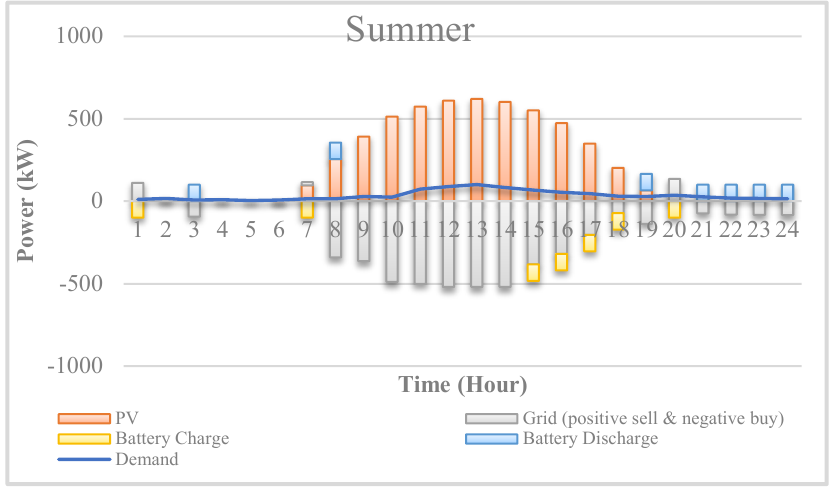
Figure 10. The bidding power of the VPP in summer.